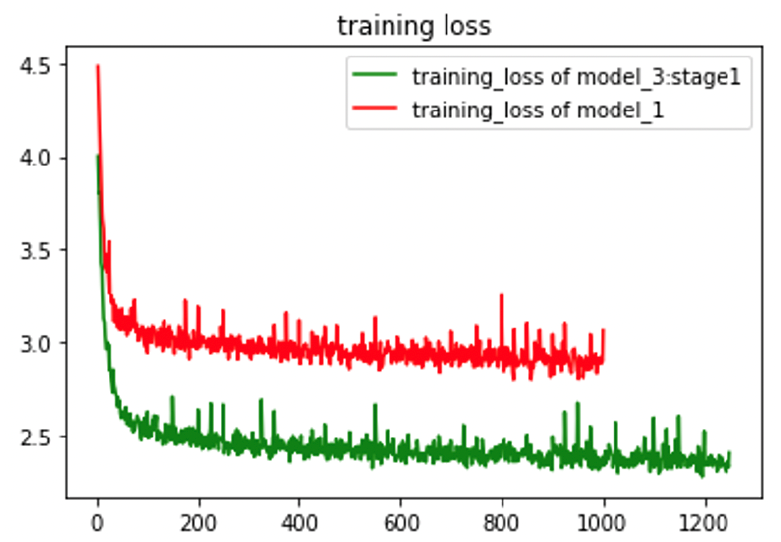
Figure 9. Training loss of model_1 and model_3: